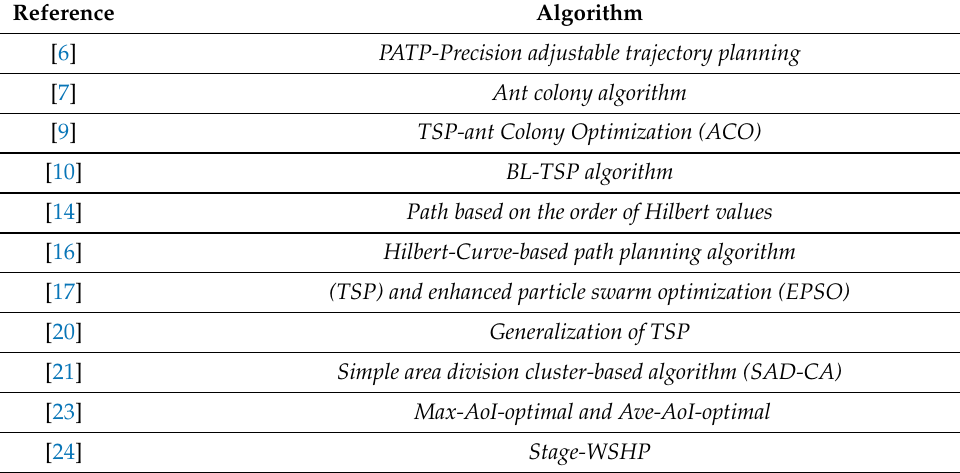
Table 5. Algorithm used in routing.